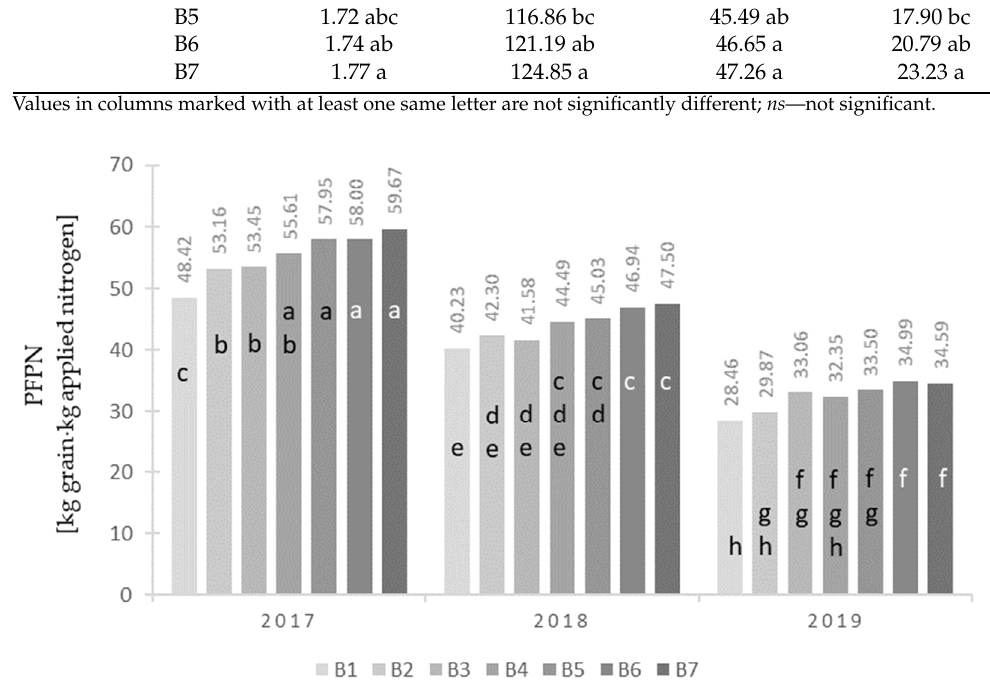
Figure 4. Average PFPN values (kg grain · kg applied nitrogen) for the combination of years (Y) and fertilizer (B). Values marked with at least one same letter are not significantly different.